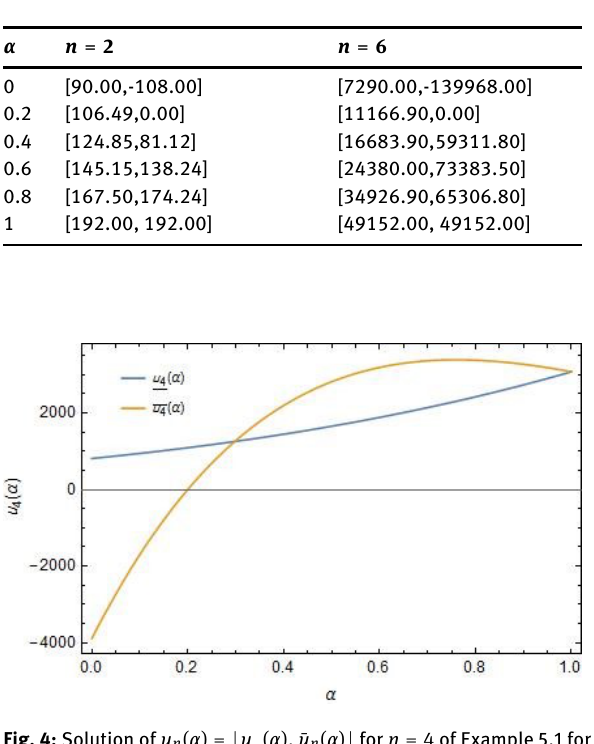
Fig. 4: Solution of u n ( α ) = ⌊ u n ( α ), ¯ u n ( α ) ⌋ for n = 4 of Example 5.1 for Type